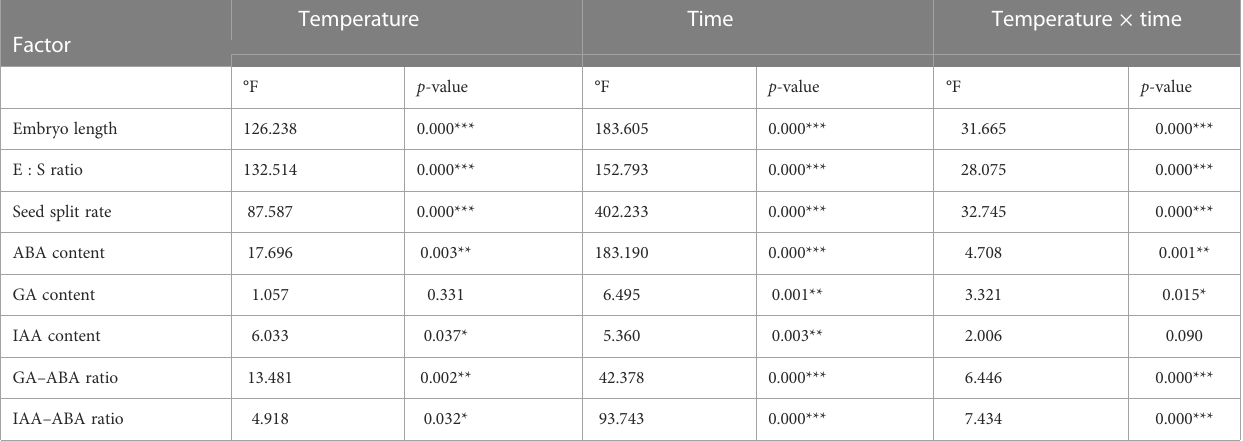
TABLE 1 Effects of seasonal temperature regimes and time on embryo growth and endogenous hormones in Taxus chinensis var. mairei seeds. Temperature Time Temperature × time Factor p -value